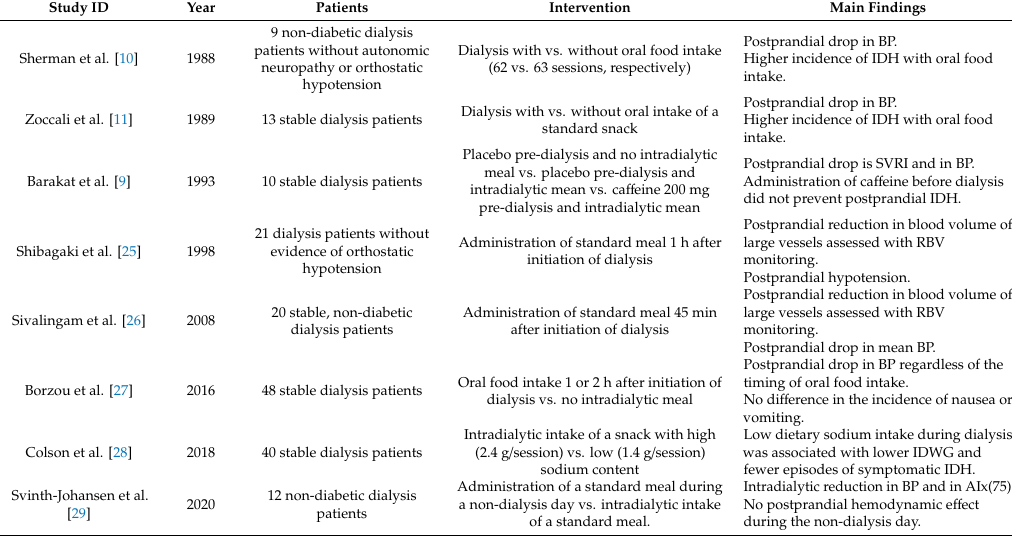
Clinical studies investigating the e ff ect of feeding during dialysis on intradialytic hemodynamic